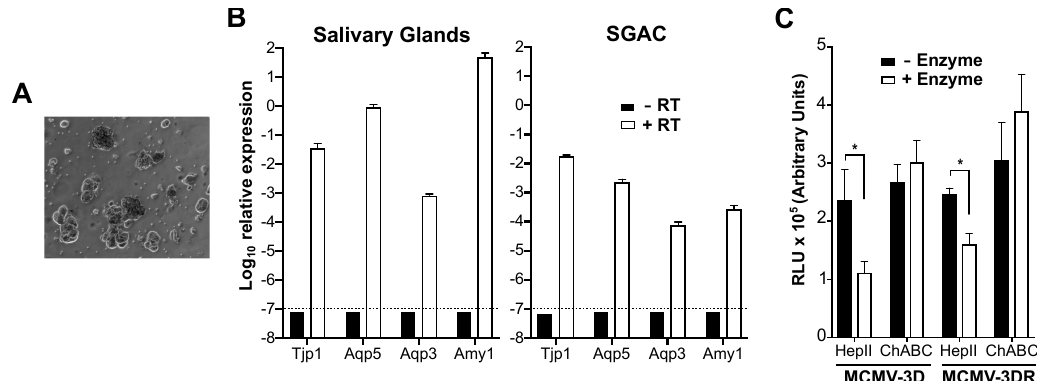
Figure 2. MCMV infection of mouse salivary gland acinar cells is independent of MCK-2 and promoted by cell surface heparan sulfate. ( A ) Appearance of cultured purified primary salivary gland acinar cells (SGACs). A representative 20 × bright field image is shown one day after isolation. ( B ) Purified SGACs maintain their molecular phenotype in culture. qPCR analysis of the relative expression of common SGAC markers ( Tjp1 , tight junction protein 1; Aqp5 , aquaporin 5; Aqp3 , aquaporin 3; Amy1 , amylase 1) in whole mouse salivary glands or cultured SGACs (as indicated above each graph). The expression of each gene relative to the expression of Gapdh in retrotranscribed ( + RT, white bars) or non-retrotranscribed (-RT, black bars) RNA samples is indicated. The dashed horizontal lines mark the detection limit. Data are represented as the mean ± SD of triplicates from one experiment representative of two independent experiments. ( C ) MCMV infection of SGACs. 5 days after isolation, SGACs pretreated ( + Enzyme, white bars) or not (-Enzyme, black bars) with the GAG lyases (HepII or ChABC) indicated on the x-axis were infected with 10,000 pfu of the Gaussia luciferase reporter viruses MCMV-3D or MCMV-3DR, and the RLUs in 10 µ L of supernatant was determined 18 hpi by luminometry. Data are presented as the mean ± SD of triplicates from one experiment representative of three independent experiments. Statistically significant di ff erences were determined by multiple t tests (*, p <